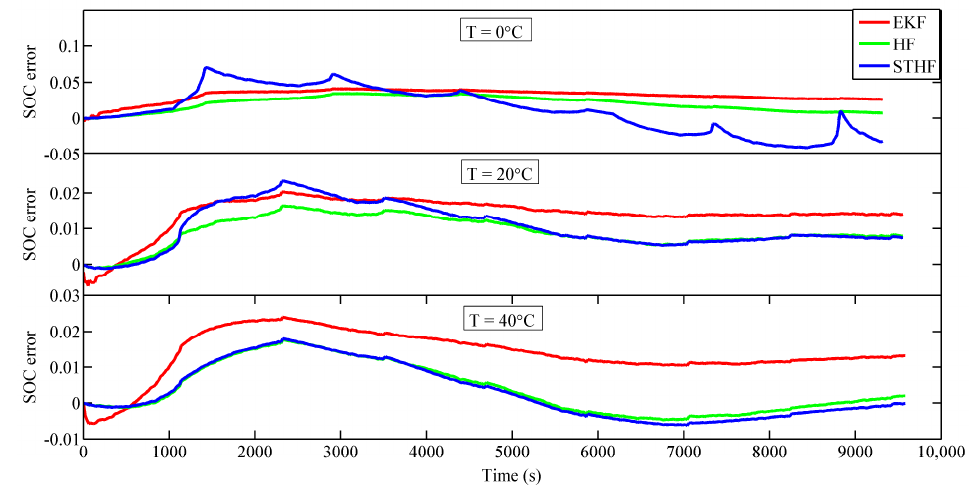
Figure 6. Estimation results of strong tracking H-infinity filter (STHF), H-infinity filter (HF), and extended Kalman filter (EKF) with white Gaussian noises.